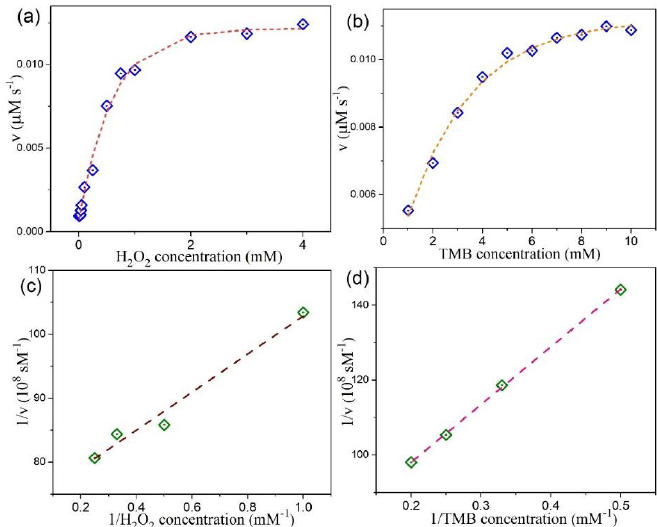
Figure 9. Steady-state kinetic analysis for MoSe 2 QDs. The reaction velocity (v) was measured when ( a ) the H 2 O 2 concentration was varied while the concentration of TMB was 5 mM and ( b ) the TMB concentration was varied while the concentration of H 2 O 2 was 0.75 mM. The corresponding double-reciprocal plots with a fixed concentration of one substrate relative to varying the concentration of the other substrate are displayed in ( c , d ).